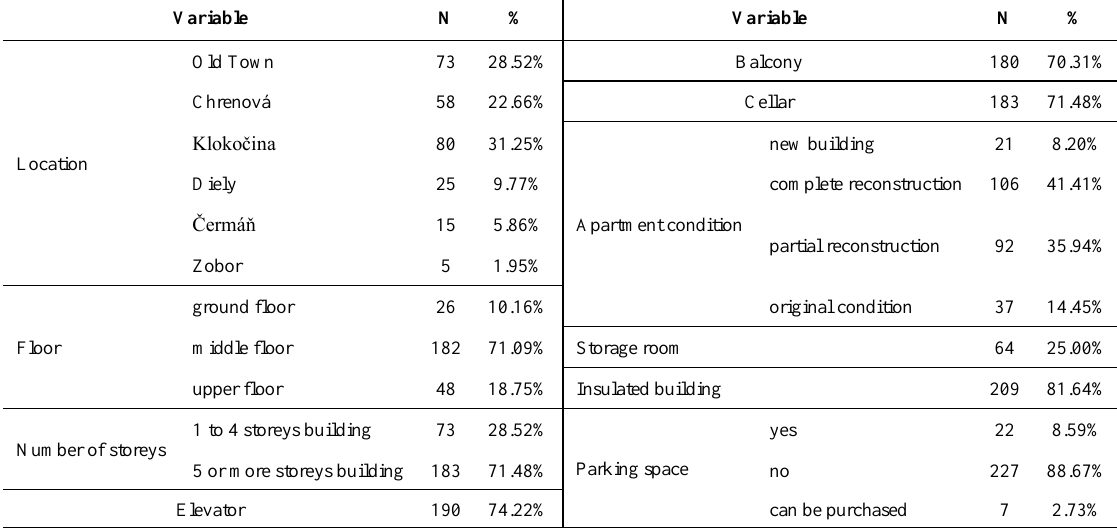
Table 2. Descriptive statistics for qualitative